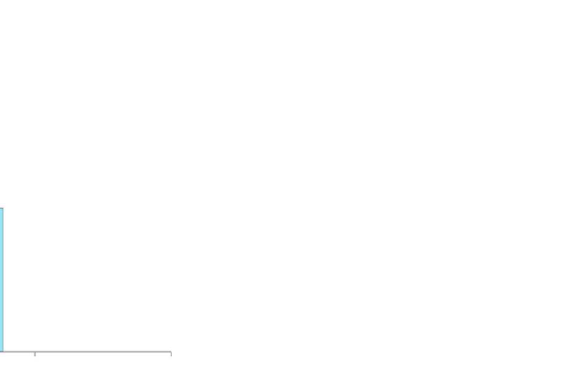
Table 1. Number of differentially expressedgenes in leaves, roots and nodules between SA36 and SA118. These numbers represent genes that were differentiallyexpressedbetweenSA36 and SA118 under N-fixing conditions, but not under non-fixingconditions. Tissue Organ Comparison